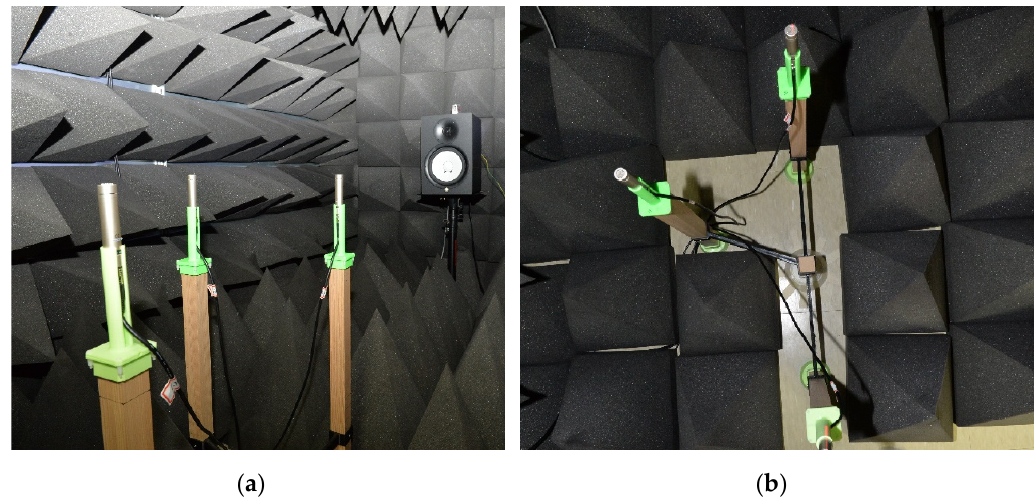
Figure 13. Acoustic experiment in the anechoic chamber: ( a ) three microphones and one speaker configuration with laser guidance; ( b ) top-view of the receiver structure and angular movement engager (the center pole).